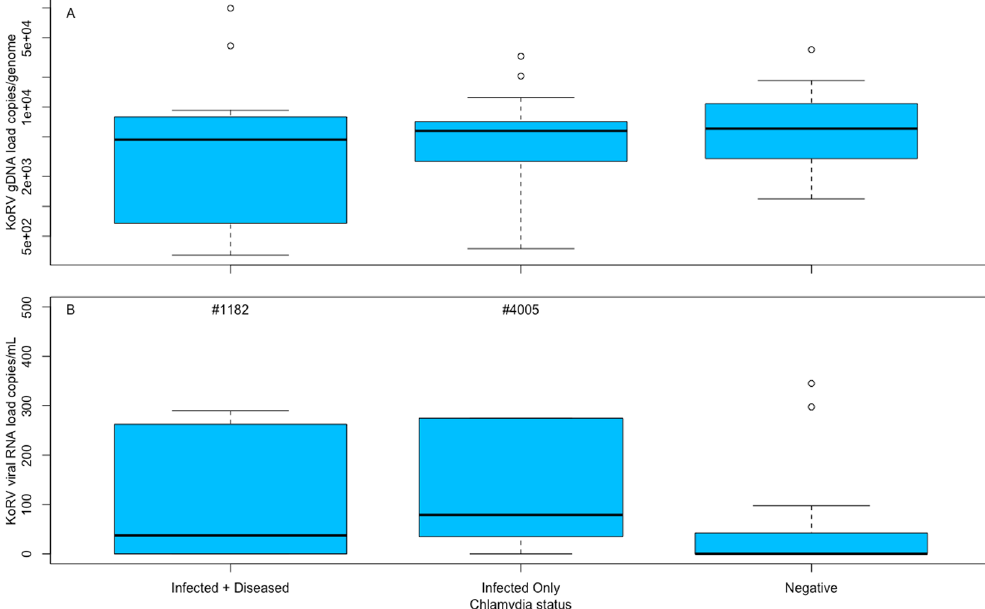
Figure 3. ( A ) Median (Interquartile Range) koala retrovirus (KoRV) genomic DNA load (copies/genome), as measured by qPCR, in DNA extracted from blood in koalas ( Phascolarctos cinereus ) and ( B ) Median (Interquartile Range) KoRV viral RNA load (copies/ul) as measured by qPCR in plasma of koalas. Koalas separated into the following groups: (1) koalas that progress to chlamydial disease (Infected + Diseased; n = 13); (2) koalas that are ‘infected but with no clinical disease’ (Infected Only; n = 10); and (3) Negative animals (that remained Chlamydia negative for longer than 12 months; n = 13). The width of the boxes is drawn proportional to the square root of the number of data values. Outliers not shown on axes (but included in analyses) are indicated by #.